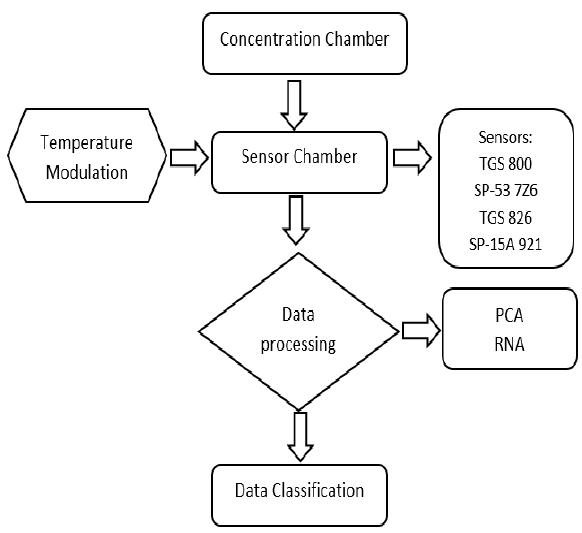
Figure 3. Scheme of measurement and data analysis.